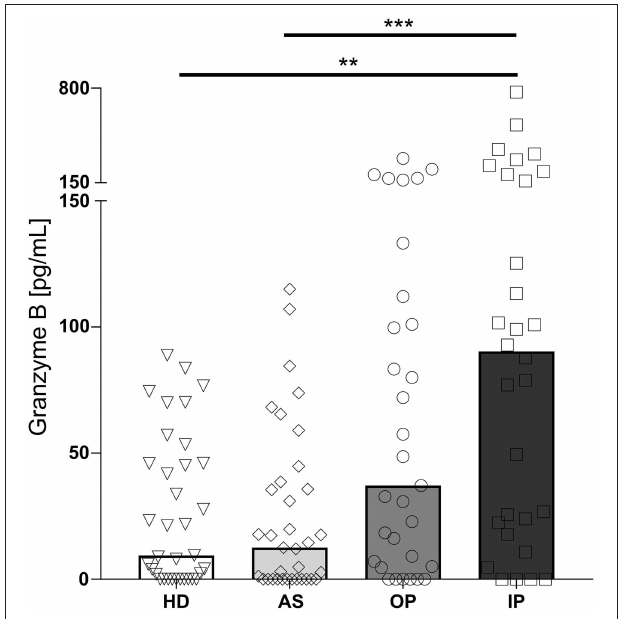
FIGURE 1 | Granzyme B level in the plasma of P. falciparum infected children is associated with disease severity. Blood samples were taken from healthy, non-infected children (healthy donors, HD; n = 41) and asymptomatically infected children (AS, asymptomatically infected; n = 41) as well as from children with uncomplicated malaria (outpatients, OP; n = 35) and severe malaria (inpatients, IP; n = 32). Granzyme B levels in the plasma were measured by ELISA. Statistical significance was determined using Kruskal–Wallis Test with post-hoc Dunn’s test: **** p < 0.0001; *** p < 0.001; ** p < 0.01; * p <